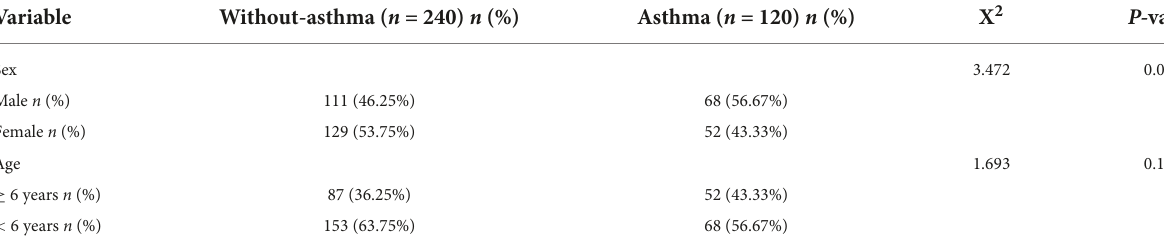
TABLE 1 Baseline characteristics of children with MPP with and without